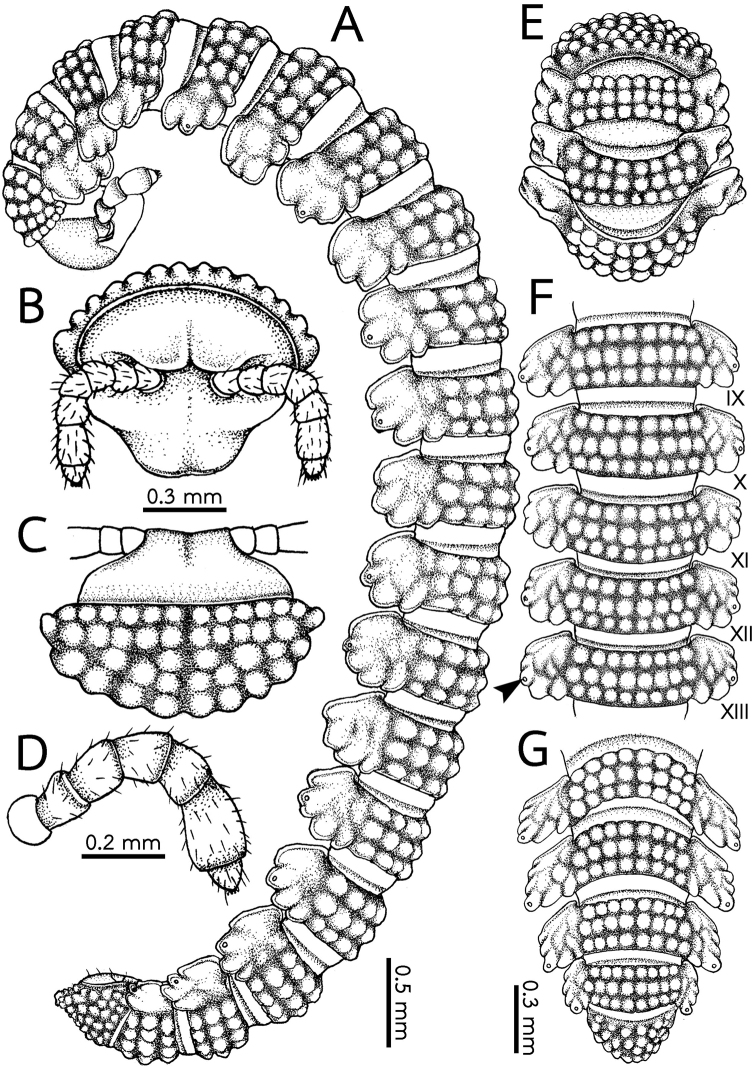
Eutrichodesmus
cambodiensis sp. nov., male paratype (CUMZ–hpd0002) A whole body part B head and antenna C head and collum D antenna E anterior body part F body rings 9–13 (arrowhead points to ozopore) G posteriormost body rings and telson A lateral view B anterior view C, E–G dorsal view. Scale bars: 0.3 mm (B, C), 0.3 mm (E–G).